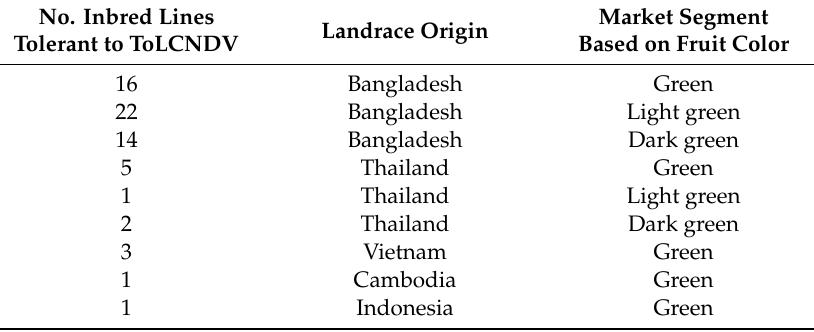
Table 5. Sponge gourd lines (65) of di ff erent market segments tolerant to ToLCNDV, developed at World Vegetable